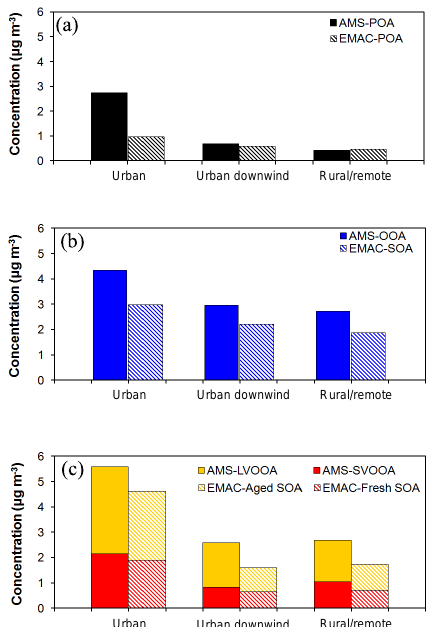
Figure 10. Comparison of average (a) EMAC predicted POA (sum of fPOA and bbPOA) to AMS-POA (sum of AMS-HOA and AMS- BBOA), (b) EMAC predicted SOA to AMS-OOA, and (c) EMAC predicted fresh and aged SOA to AMS-SVOOA and AMS-LVOOA from 84 data sets over urban, urban downwind, and rural/remote areas during